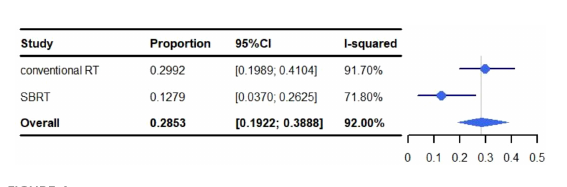
FIGURE 4 Meta-analysis and forest plots for non-small cell lung cancer patients treated with radiotherapy/chemoradiotherapy and immune checkpoint inhibitors who experienced grade 1-5